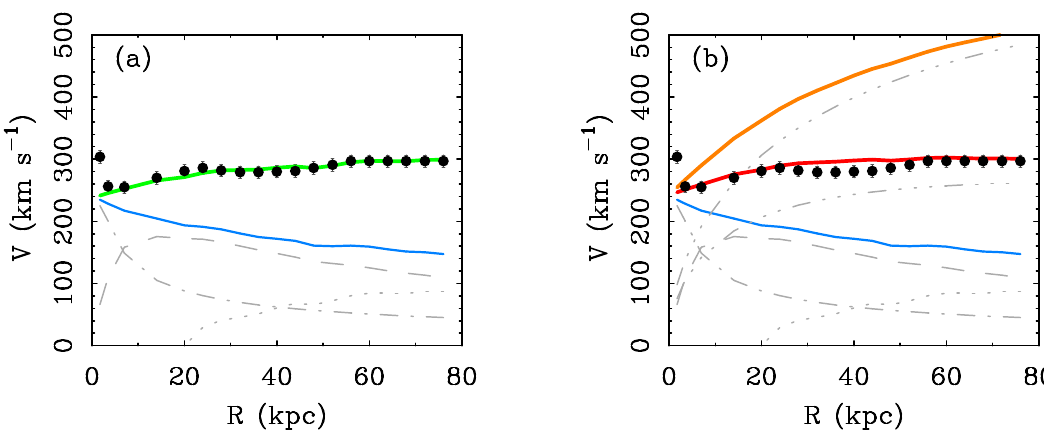
Figure 5. Rotation curve and mass models for the giant spiral galaxy UGC 2885 ( M ∗ ≈ 2 × 10 11 M (cid:12) ) in ( a ) MOND and ( b ) Λ CDM. Mass models of the individual components are shown as gray lines: dotted for the gas, dashed for the stellar disk (for Υ ∗ = 0.5 M (cid:12) /L (cid:12) at [3.6]), dash-dotted for the bulge ( Υ ∗ = 0.7 M (cid:12) /L (cid:12) ), and dash-triple dotted for the dark matter halos in ( b ). A thin blue solid line shows the sum of baryonic components: this is the expected rotation without dark matter or MOND. A thick solid line shows the corresponding rotation that is predicted in MOND (green line in a ) and Λ CDM (red and orange lines in ( b )). In the latter case, two approaches are taken to predict the mass of the dark matter halo (see text). Assuming m d = 0.05 [69] results in the red line that performs almost as well as MOND. Using abundance matching [73] results in the orange line that overshoots the